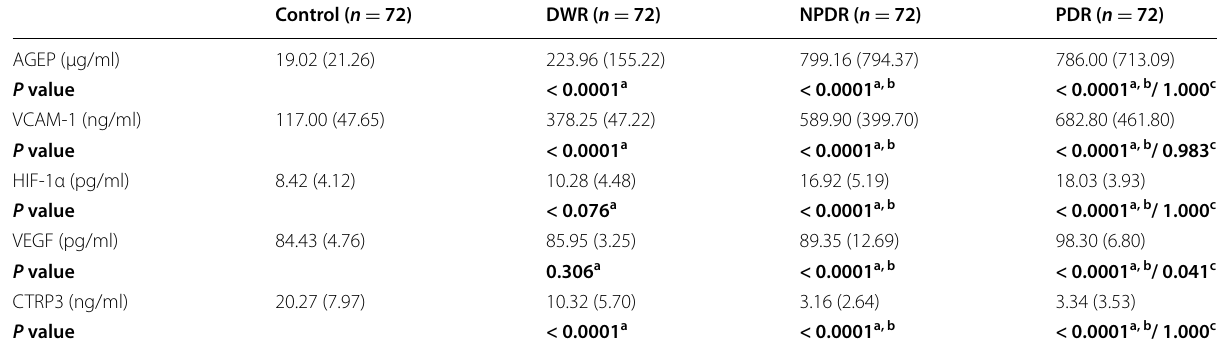
Data are expressed median (interquartile